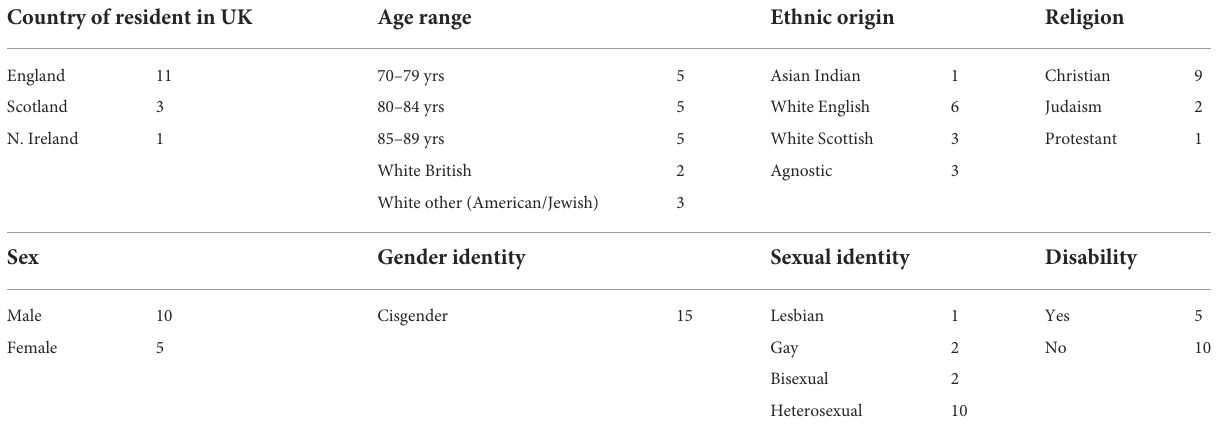
FIGURE1 Schematic diagram of qualitative themes.